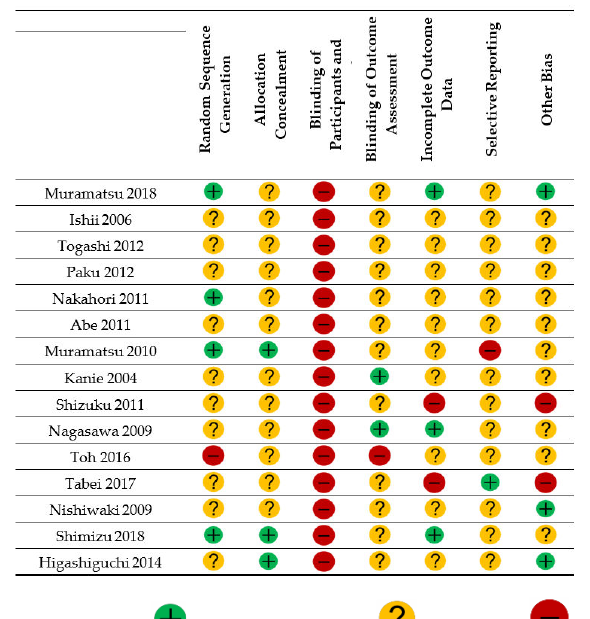
Figure 2. Risk of bias summary. = low risk of bias; = unclear; = high risk of